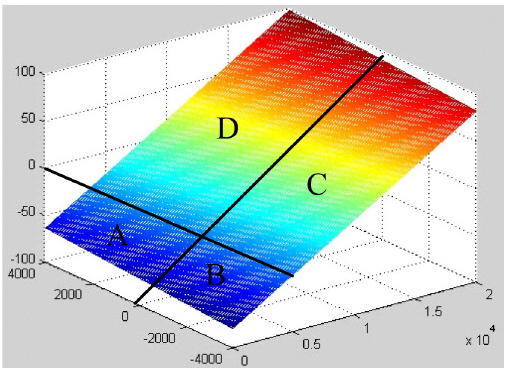
Figure 5. Relationship between GDP, International Oil Price and Carbon